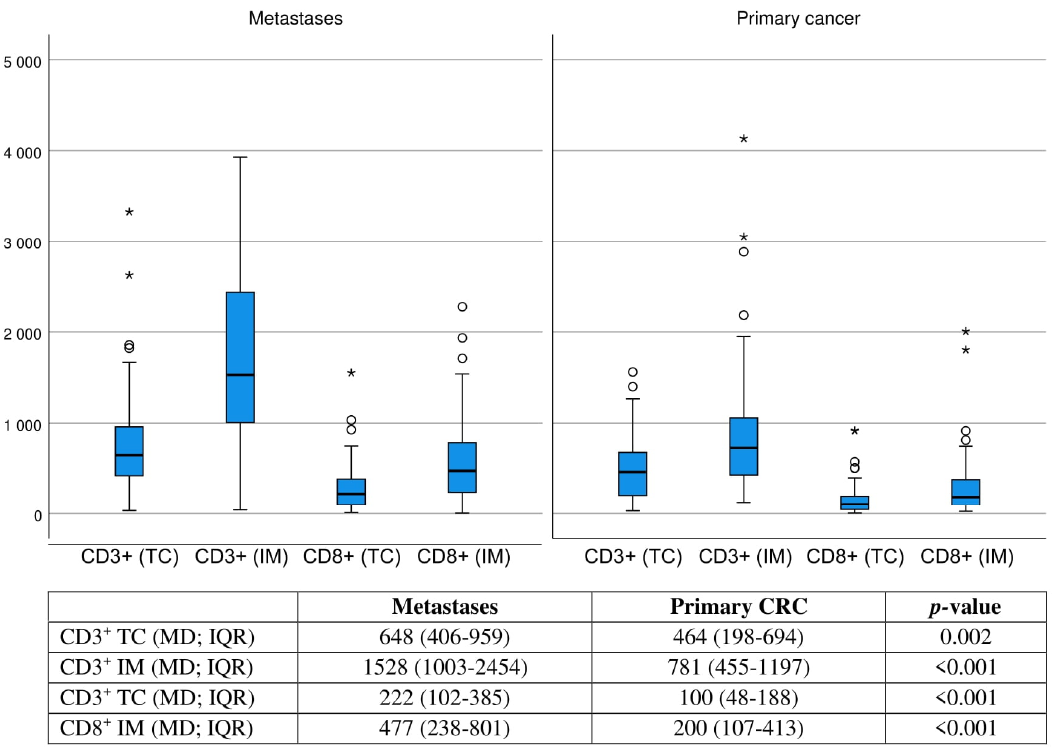
Figure 2. Boxplot of CD3 + and CD8 + densities (cells/1 mm 2 ) at the tumour centre and invasive margin of first pulmonary metastases ( n = 67) and primary tumour samples ( n = 63). Mann–Whitney U -test was applied. Circles indicates outliers. Asterisks indicates extreme outliers.